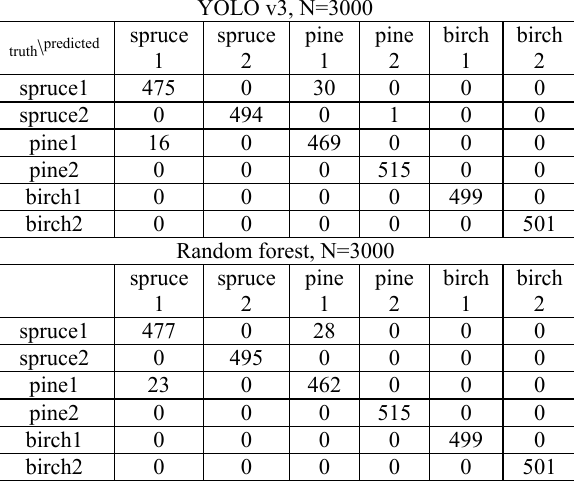
Table 4. Confusion matrices for YOLO v3 and Random Forest classifiers trained with 1000 reference tree for each tree species. The number 1 refers to an illuminated case and the number 2 to a shadowed case.